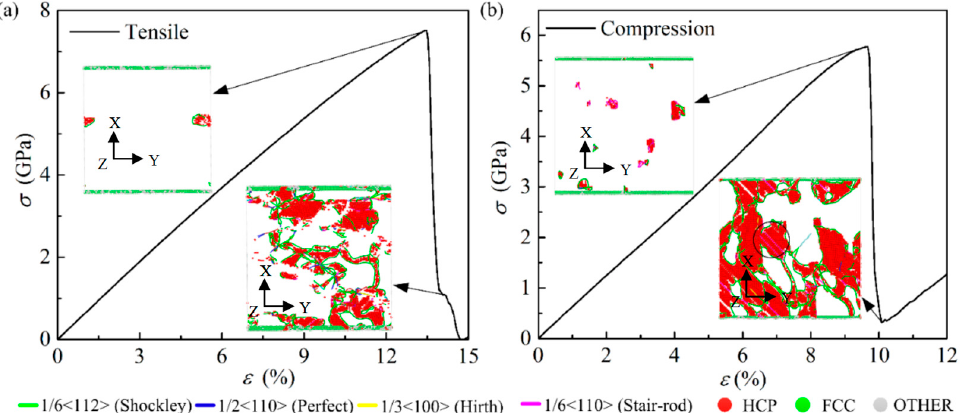
Figure 6. Stress-strain curve and dislocation analysis of pure Al at different loading patterns. ( a ) Uniaxial tension and ( b ) uniaxial compression. The insets figures present the atomic structure by common neighbor analysis for the dislocation emitted under tension and compression loading. The green and red atoms represent FCC and HCP atoms,